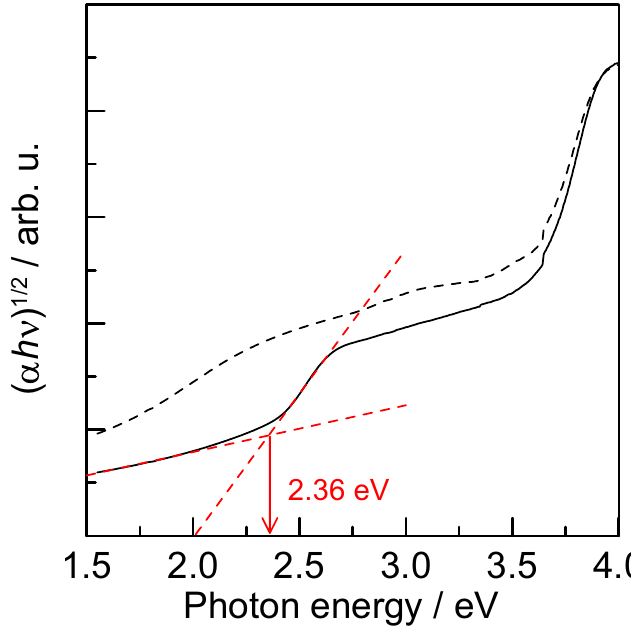
Figure 9. Dependence of ( αhν ) 1/2 on photon energy hν (Tauc plot) for samples sintered at 300 °C (dashed line) and 500 °C (solid